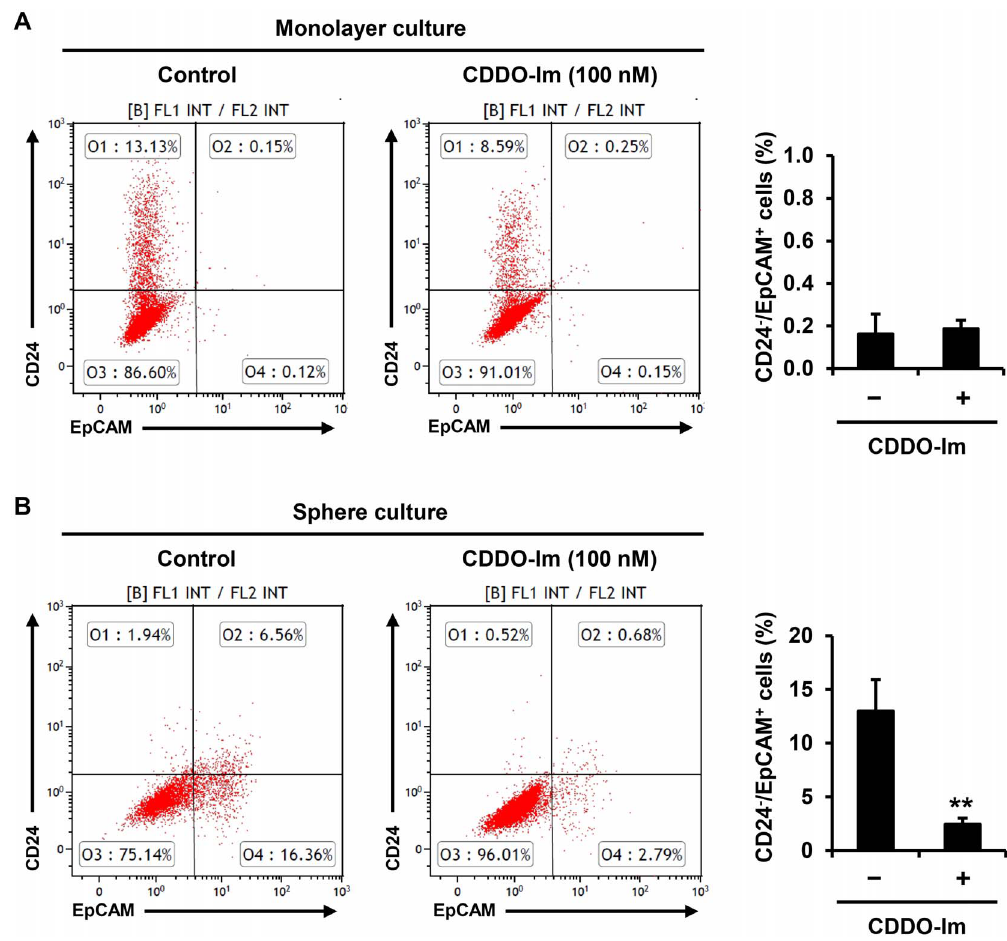
Figure 3. Enrichment of the CD24 2 /EpCAM + subpopulation in tumorspheres of SUM159 cells and its repression by CDDO-Im. ( A ) SUM159 cells were treated with vehicle control or CDDO-Im (100 nM) for 24 h in monolayer culture. Then, SUM159 cells were stained with CD24 and EpCAM, and the number of cells in each subpopulation (CD24 2 /EpCAM + , CD24 2 /EpCAM 2 , CD24 + /EpCAM + and CD24 + /EpCAM 2 ) was determined by flow cytometry. Three separate experiments were conducted, and average percentages of CD24 2 /EpCAM + subpopulation are shown in the graph. ( B ) SUM159 cells were treated with vehicle control or CDDO-Im (100 nM) for 7 days in sphere culture. Then, SUM159 cells were stained with CD24 and EpCAM, and the number of cells in each subpopulation (CD24 2 /EpCAM + , CD24 2 /EpCAM 2 , CD24 + /EpCAM + and CD24 + /EpCAM 2 ) was determined by flow cytometry. Three separate experiments were conducted, and average percentages of CD24 2 /EpCAM + subpopulation are shown in the graph (**p ,